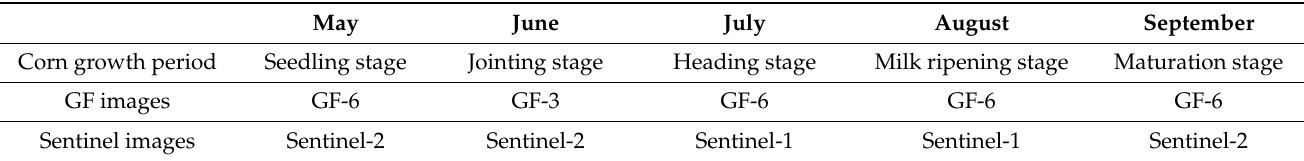
Table 2. Image acquisition at each growth